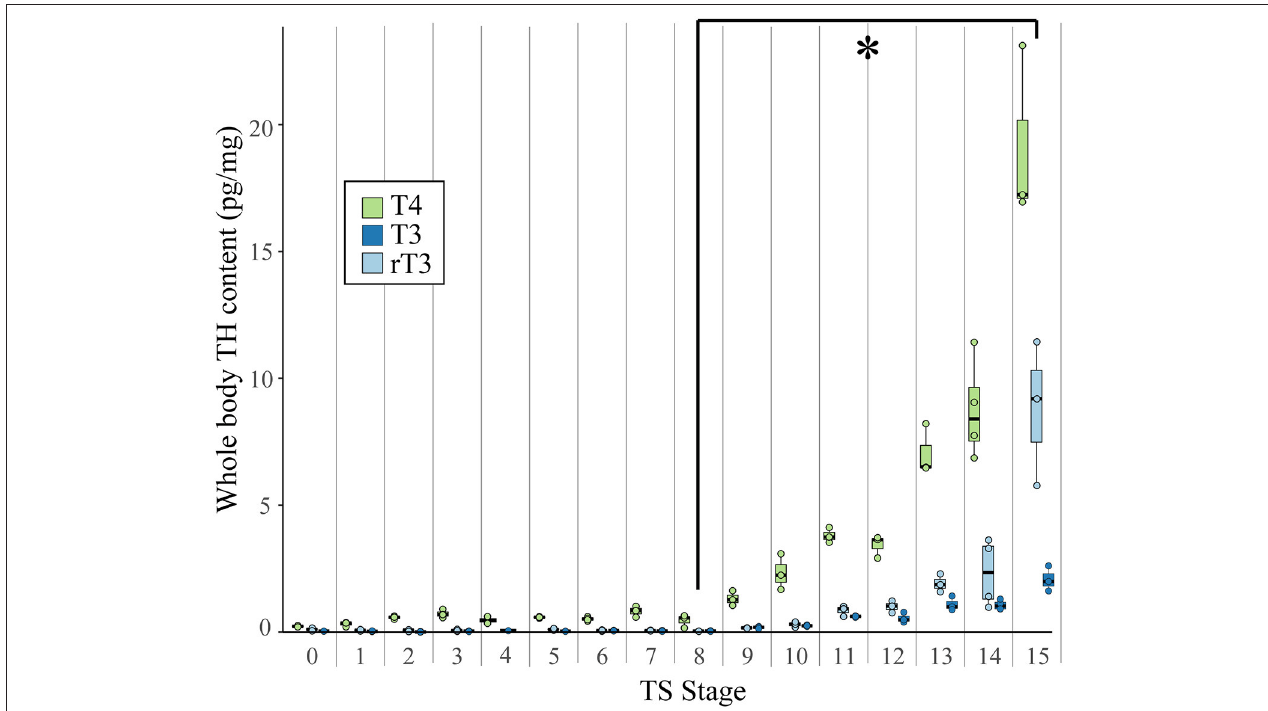
FIGURE 2 | Whole body content of T 4 , T 3 , and rT 3 in pooled E. coqui embryos at TS stages 1–15 and in unfertilized oocytes (TS 0) as quantified by LC-MS/MS. Whole body content of iodothyronines was normalized to sample weight; between 15 and 20 embryos were pooled to generate one biological replicate. Each value depicted in the graph is based on two-to-four replicates. Values based on fewer than three replicates are not included in the statistical analysis. All three iodothyronines increased significantly between TS stages 8 and 15 ( post-hoc Dunn’s test; p < 0.05), indicated by the asterisk (*). See Supplementary Data for a complete list of significant pairwise differences. Each boxplot represents median and range of the data.